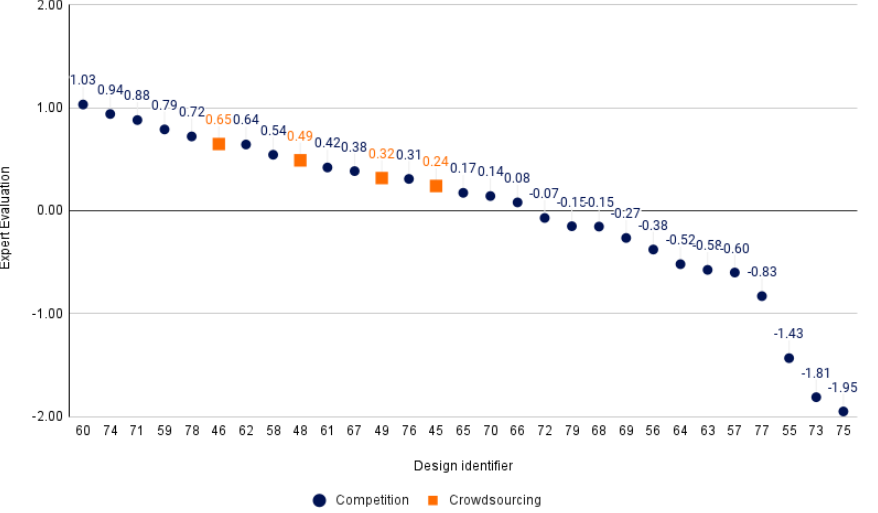
Figure 6. The results of the experts’ rating of competition designs and the designs obtained in the community design